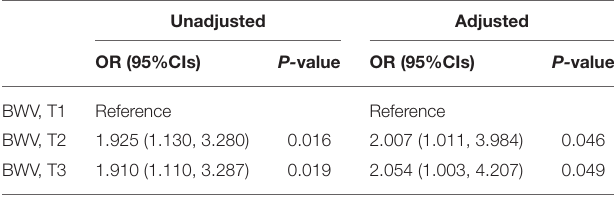
TABLE 3 | Binary logistic regression of BWV for rapid progression of CAC in subjects with BW maintenance during follow-up periods. Unadjusted